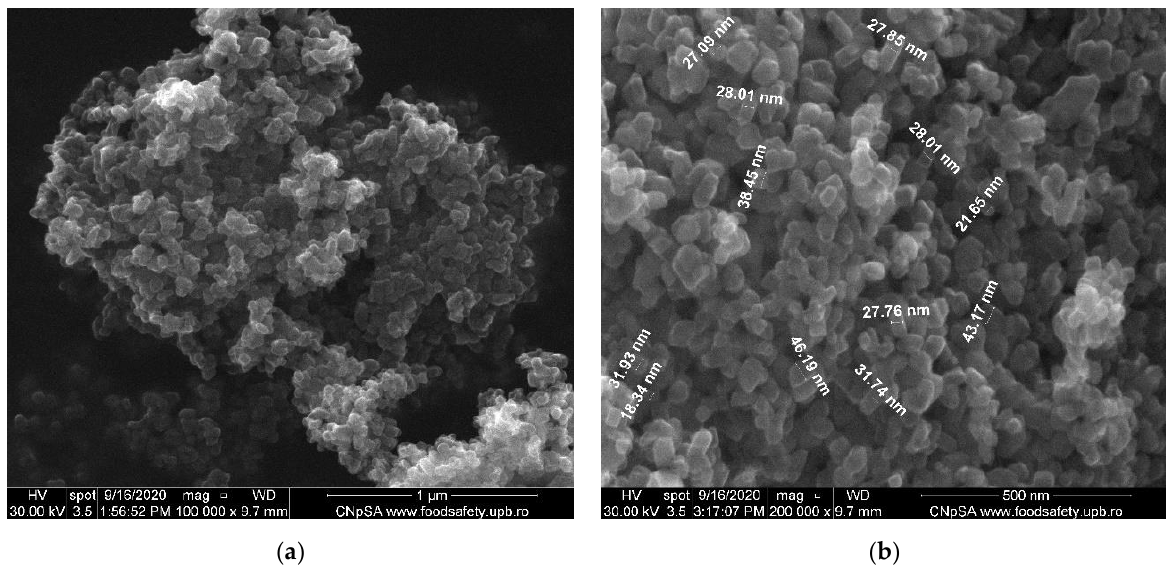
Figure 7. SEM images of TiO 2 nanoparticles: ( a ) 100.000× magnification, ( b ) 200.000× magnification. The morphology of the simple chitosan (CS) membrane is presented in Figure 8.